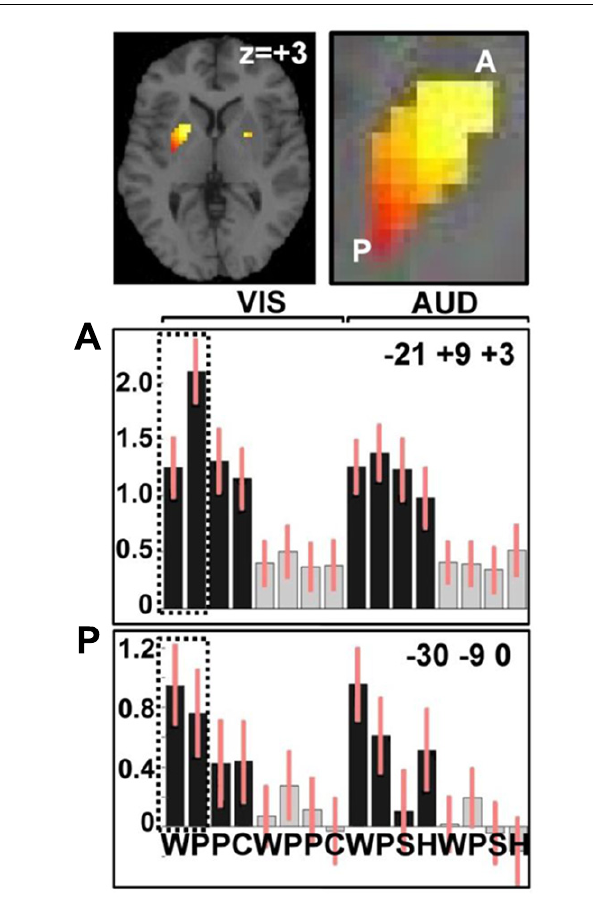
FIGURE 2 |Activation in the anterior and posterior putamen. Top: activation in the putamen for reading words and pseudowords compared to naming objects and colors. A close up of the left putamen labels anterior putamen (A) and posterior putamen (P). Plots show relative activation for each of the 16 conditions in (A) at MNI co-ordinates x = − 21, y = + 9, z = + 3 and (P) at MNI co-ordinates x = − 30, y = − 9, z = 0.Values on y -axis show activation relative to fixation (the baseline condition). Bars on each column indicate confidence intervals. Black represents speech tasks, gray represents one-back-matching task.The first eight columns represent the visual tasks withWPPC = word reading, pseudoword reading, picture naming, and color naming stimuli.The second eight columns represent the auditory tasks withWPSH = auditory repetition of words, auditory repetition of pseudowords, naming objects from non-verbal sounds and identifying gender of humming voice. Dotted frames highlight greater activation for pseudowords than words in anterior putamen and greater activation for words than pseudowords in posterior putamen. Details of the relevant statistics are provided in the text and Table 1 .